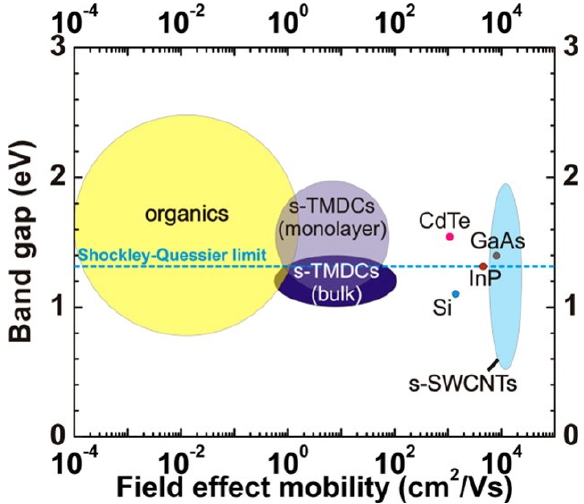
Figure 11. Bandgap vs. field-effect mobility of some important semiconductors used in optoelectronic devices. The dashed line is the band gap at ~1.34 eV while efficiency reach the Shockley-Quessier limit (~33.7%). Reproduced with permission from [188], American Chemical Society, 2014.